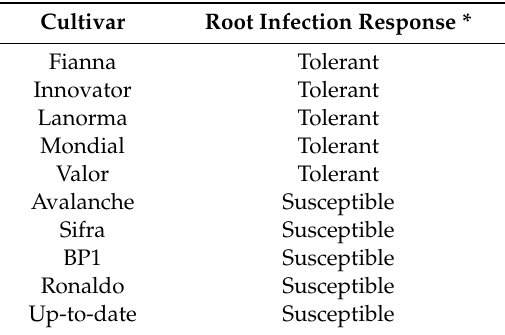
Table 4. List of 10 potato cultivars di ff ering in susceptibility levels to Spongospora subterranea f. sp. subterranea root infection used in pot